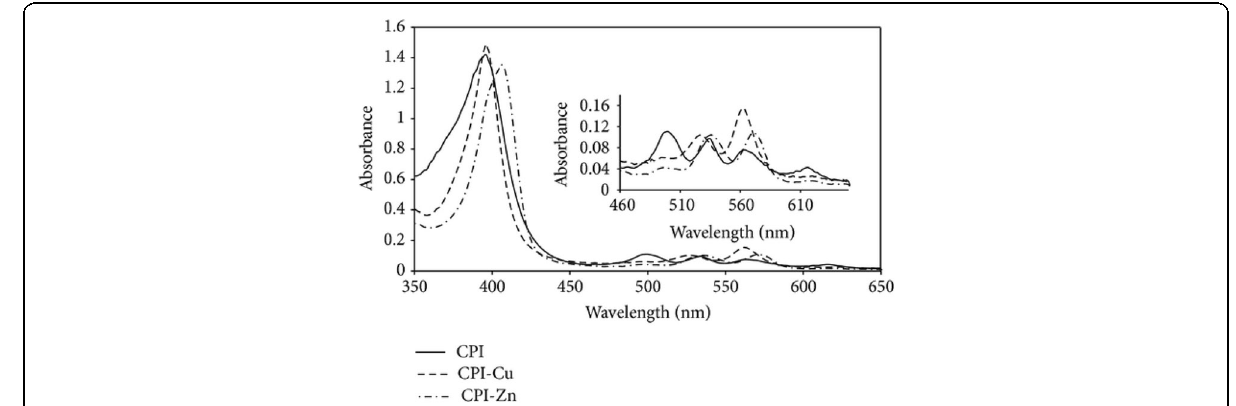
Fig. 22 UV-vis spectra and in insert Q-band magnification for CPI, CPICu, and CPIZn incorporated into the TiO 2 films [237]